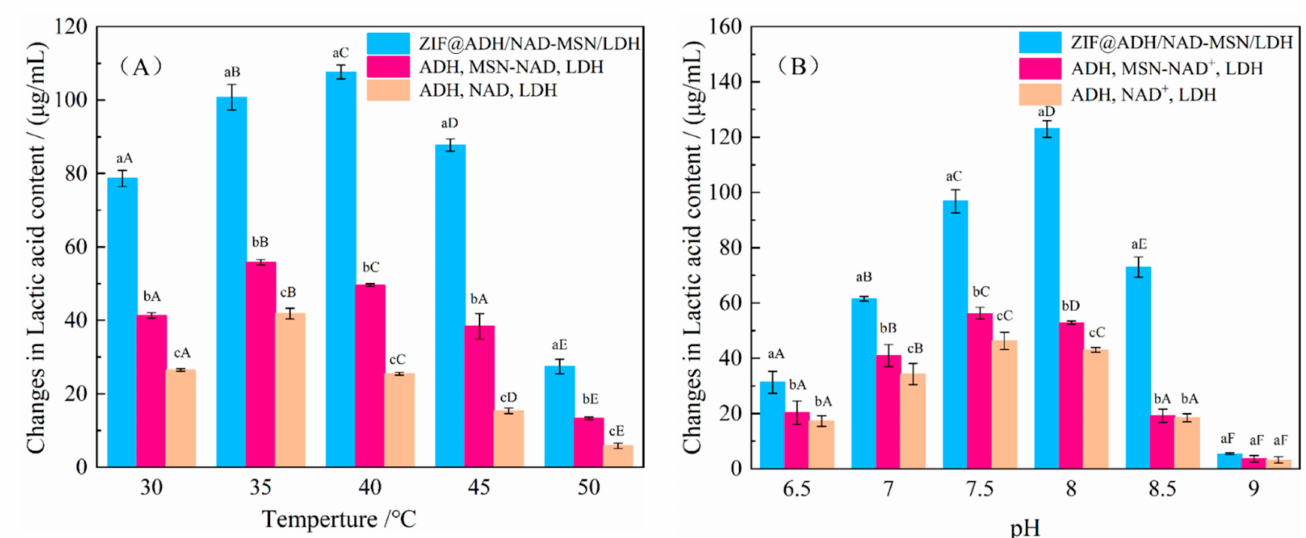
Figure 6. Changes in the content of lactic acid in the system under different conditions. ADH: Alcohol dehydrogenase; LDH: Lactate dehydrogenase; NAD + : Nicotinamide adenine dinucleotide; ZIF@ADH/NAD-MSN/LDH: Core–shell nanocomposites prepared by ZIF-8 immobilized ADH, LDH, and MSN-NAD; MSN-NAD: Mesoporous silica nanoparticles immobilized nicotinamide adenine dinucleotide. ( A ) Lactic acid synthesis concentration of three experimental groups within 3 h at different temperatures. The same lowercase letters indicated that there was no significant difference in the concentration of lactic acid synthesis in the three experimental groups at the same temperature. Different lowercase letters indicated that there was significant difference in the lactic acid synthesis concentration of the three experimental groups at the same temperature. The same capital letters represent that there was no significant difference in the concentration of lactic acid synthesis in the same experimental group at different temperatures. Different capital letters indicated that the lactic acid synthesis concentration of the same experimental group at different temperatures was significantly different. ( B ) Lactic acid synthesis concentration of three experimental groups in 3 h at different pH. The same lowercase letters indicated that there was no significant difference in the concentration of lactic acid synthesis in the three experimental groups at the same pH. Different lowercase letters indicated that there was significant difference in the lactic acid synthesis concentration of the three experimental groups at the same pH. The same capital letters represented that there was no significant difference in the concentration of lactic acid synthesis in the same experimental group at different pH. Different capital letters indicated that there was significant difference in lactic acid synthesis concentration in the same experimental group under different pH